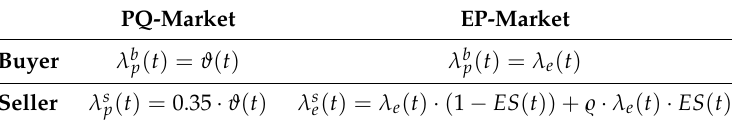
Table 1. Summary of private valuation of power